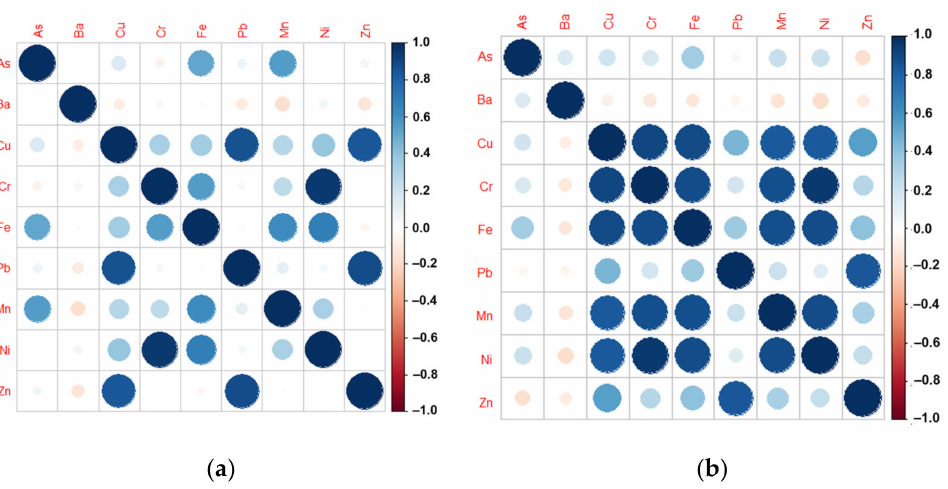
Figure 5. Correlation matrix for ( a ) Soils; ( b )